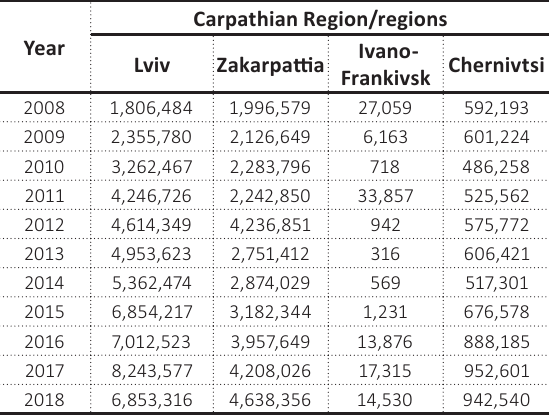
Table 2. Number of Ukrainian citizens who emigrated from the Carpathian Region in 2008–2018